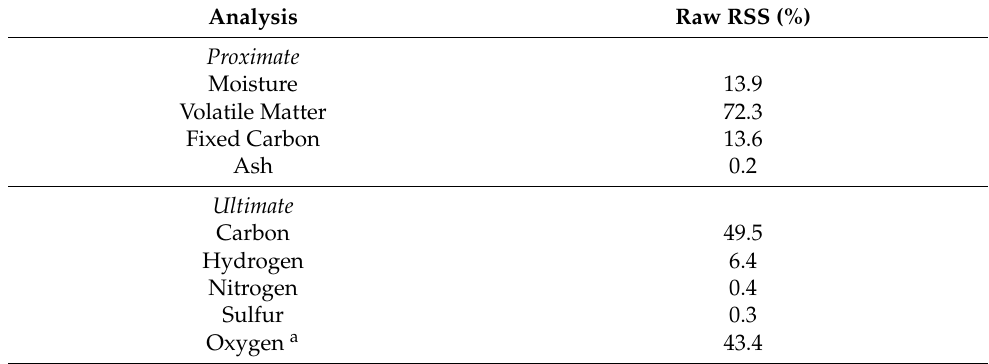
Table 1. Proximate and ultimate analysis of raw rubber seed shell